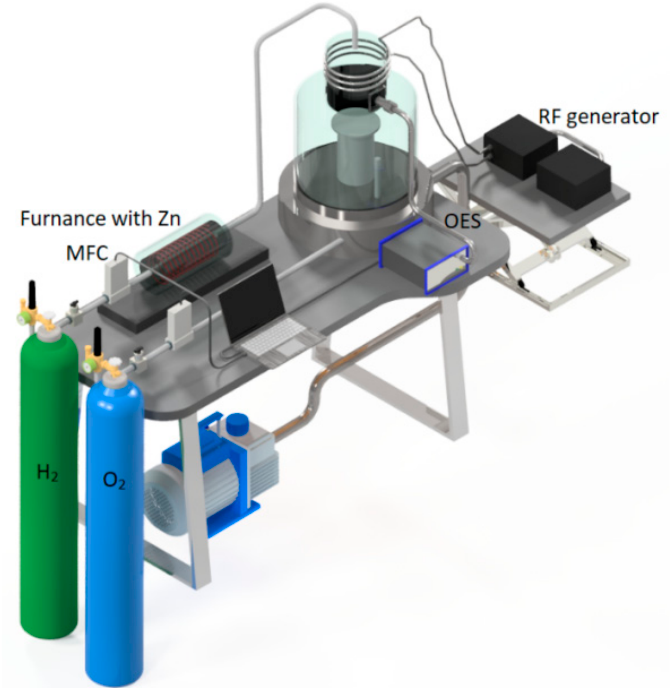
Figure 1. The scheme of a plasma–chemical installation with a pear-shaped